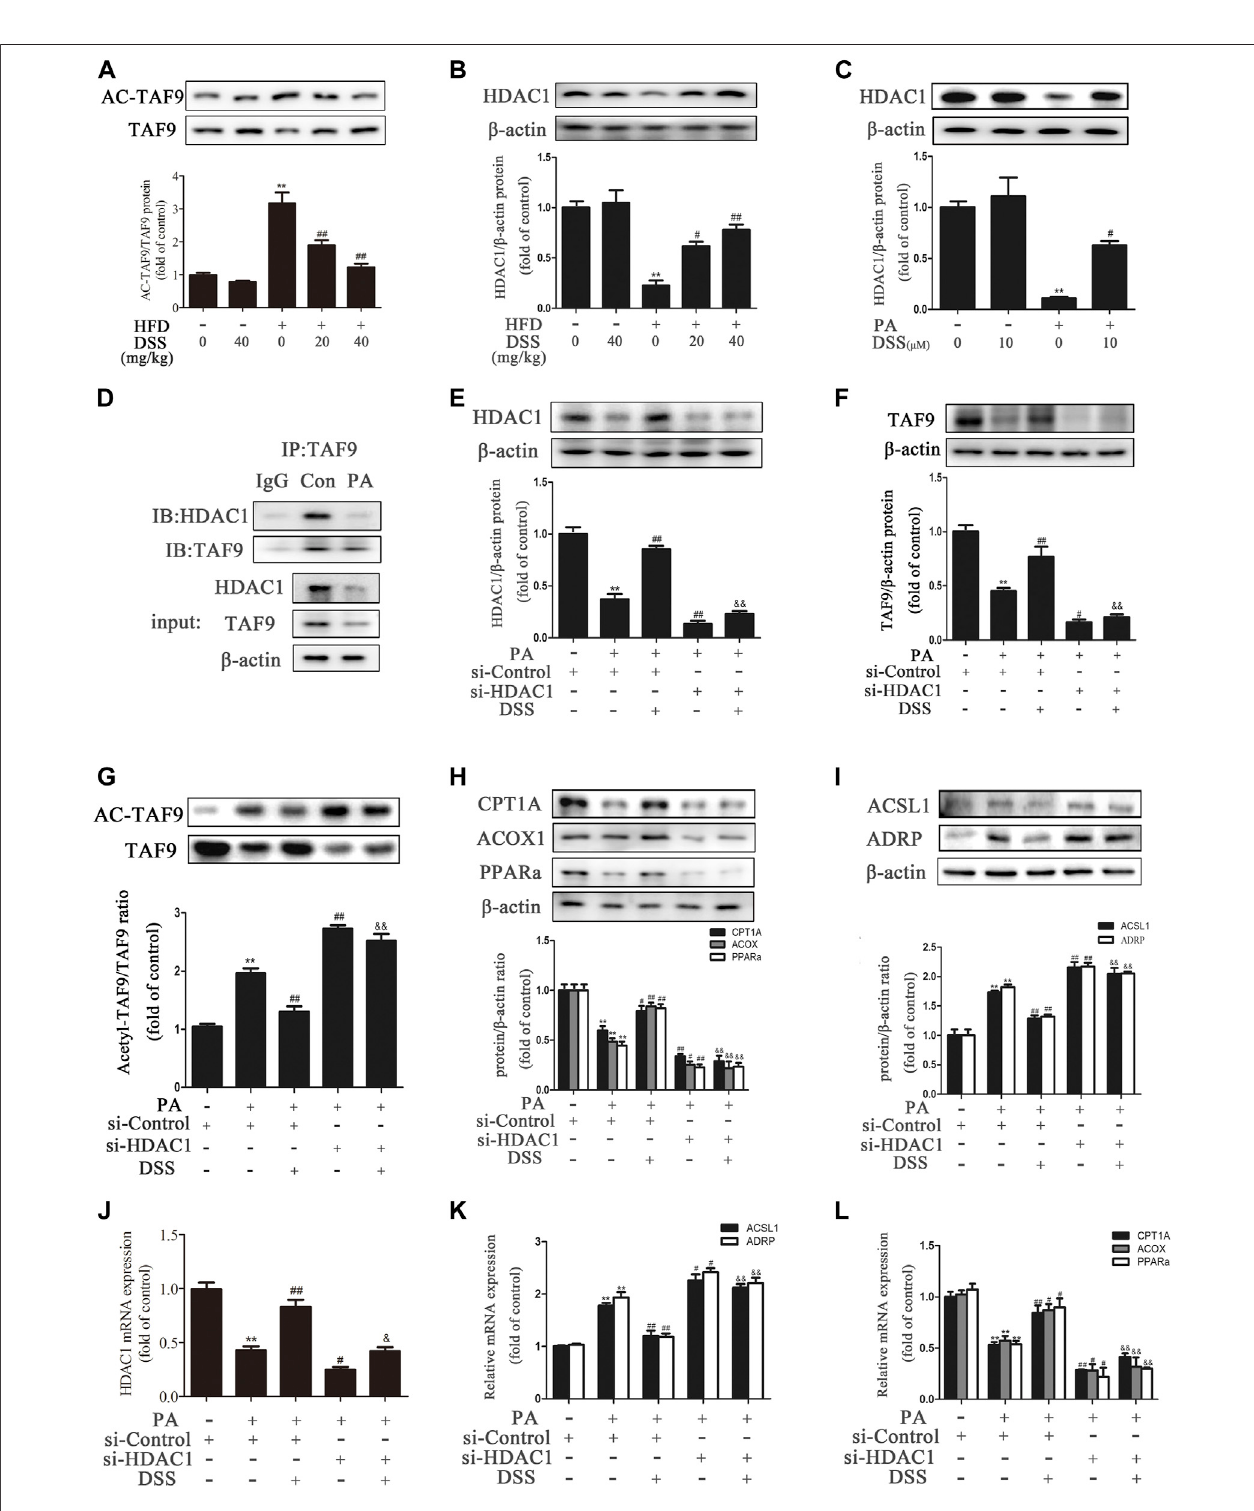
FIGURE 6 | DSS promotes TAF9-mediated increases in fatty acid β -oxidation and decreases in LD accumulation, probably through an HDAC1-dependent mechanism. (A,B) Protein levels of TAF9, TAF9 acetylation and HDAC1 in the liver ( n (cid:2) 3). ** p < 0.01 vs. the ND group; # p < 0.05, ## p < 0.01 vs. the HFD group. (C) Protein level of HDAC1 in AML-12 cells ( n (cid:2) 3). ** p < 0.01 vs. the control group; # p < 0.05vs. the PA group. (D) Representative immunoblot showing the interaction of HDAC1 with TAF9 in PA-treated AML-12 cells. The input represents the total protein extracts used for immunoprecipitation. IB, immunoblotting; IP, immunoprecipitation; IgG, negative control. (E – L) AML-12 cells were transfected with a control siRNA or HDAC1 siRNA for 48 h, and then the transfected cells were